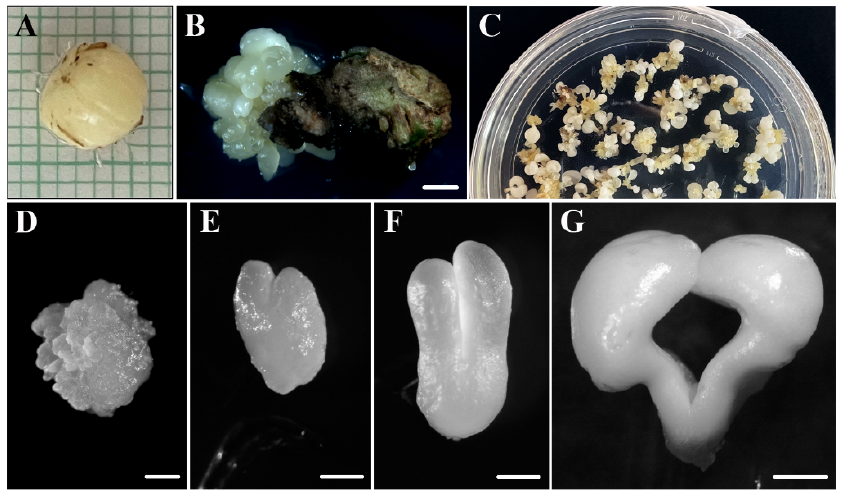
Figure 1. Main stages of somatic embryogenesis of Quercus suber . ( A ) Immature zygotic embryos. ( B ) Induction of somatic embryos from an immature zygotic embryo. ( C ) Panoramic view of a culture plate showing different structures corresponding to various developmental stages. ( D ) Proembryo- genic mass. ( E ) Heart-shaped embryo. ( F ) Torpedo embryo. ( G ) Mature cotyledonary embryo. Bars in: ( B ) 2 mm, ( C ) 1 cm, ( D – F ) 0.5 mm, and ( G ) 1